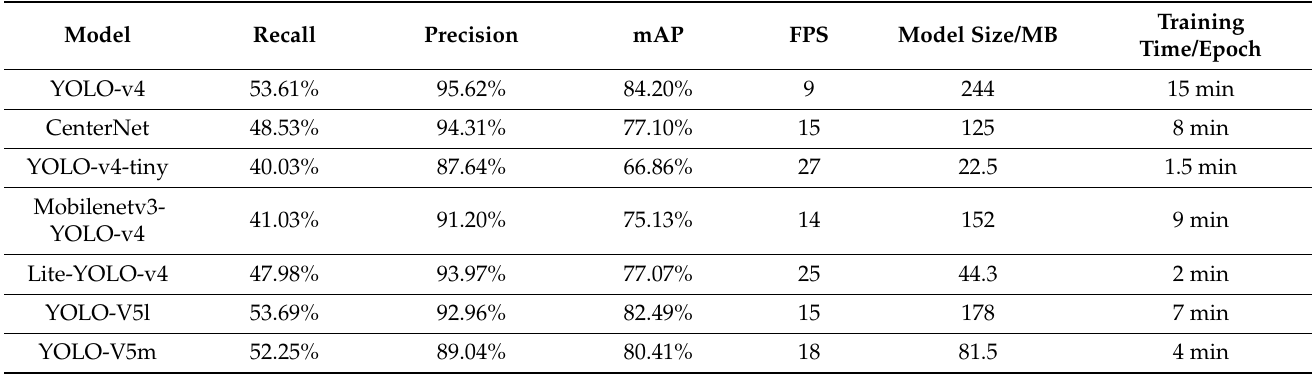
Table 2. Values of the Eight Model Indicators Under the Crack Dataset.